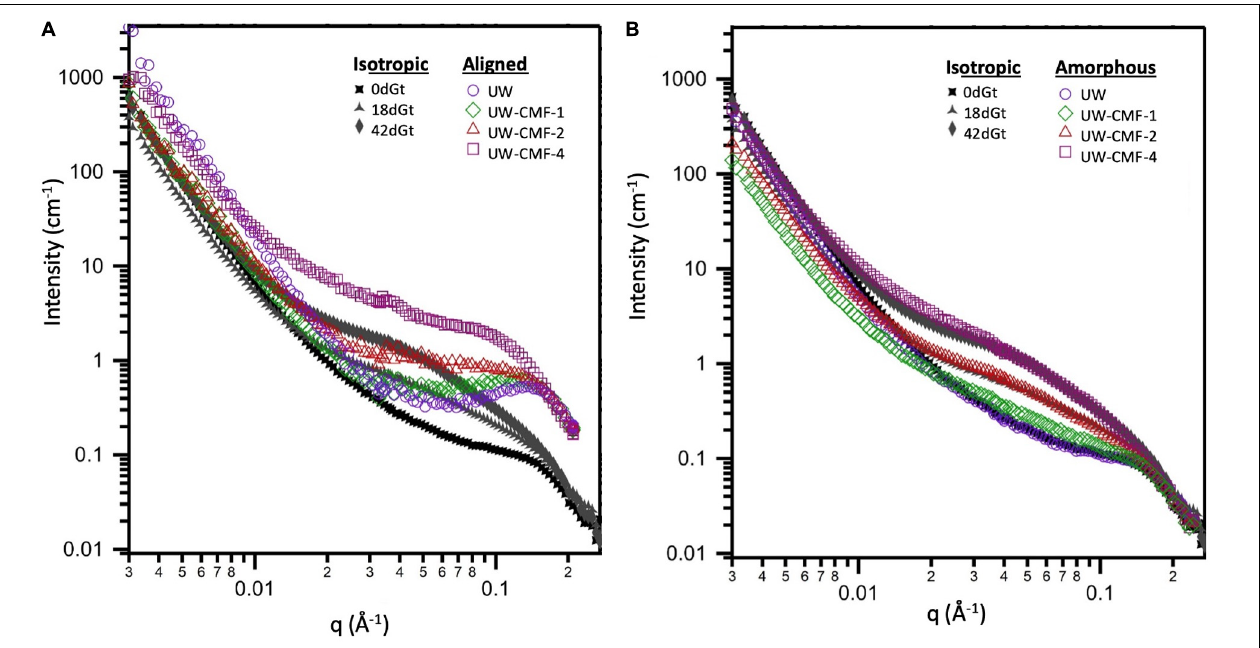
FIGURE 5 | Comparison of the effect of CMF treatment on sound wood, and decay by G. trabeum , on the wood’s nanostructure. Both (A,B) plots show the isotropic scattering profiles of the decayed samples which are plotted together with either: (A) the aligned scattering curves from the pulsed CMF-treated samples or (B) the amorphous scattering profiles from the pulsed CMF-treated samples.